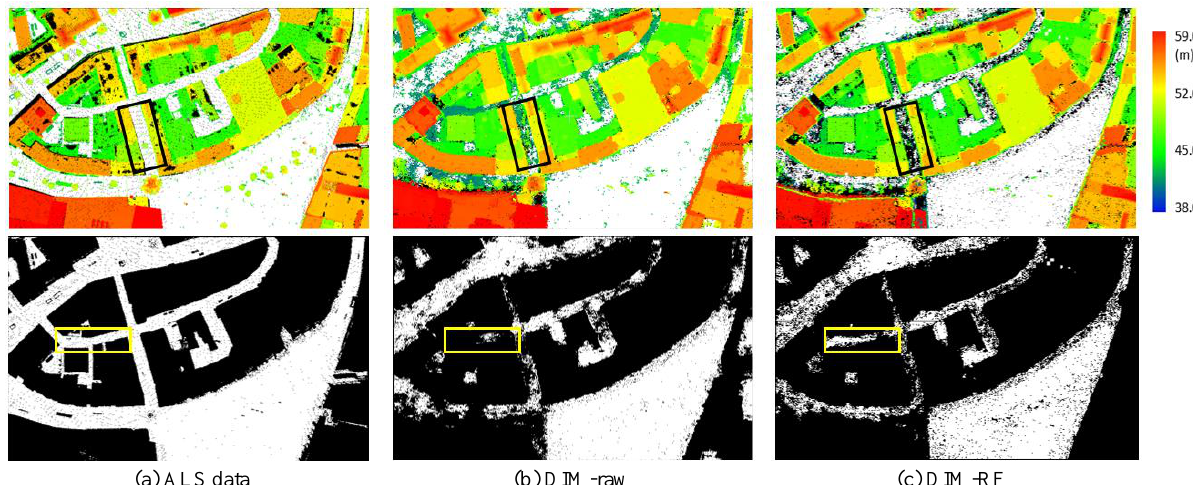
Figure 7. Filtering results of a city block. The top row shows both the ground and non-ground points. White indicates the ground points identified by LASground; black indicates data gaps. Non-ground points are colored based on the height value. The bottom row shows only the ground points. The two figures in the first column entitled (a) is the filtering effect of ALS data; (b) shows the filtering effect of the raw point clouds generated by Pix4D; column (c) shows the filtering effect of the Pix4D point cloud processed by a ranking filter. For the meaning of black and yellow boxes, please refer to the text.